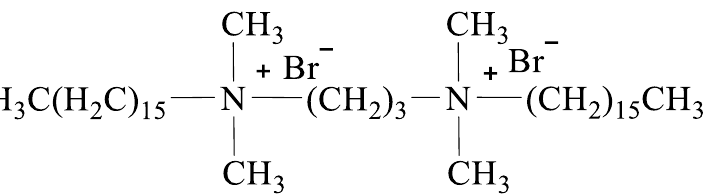
Figure 2. The molecular structure of [N 1116 C 3 N 1116 ][Br] 2 .